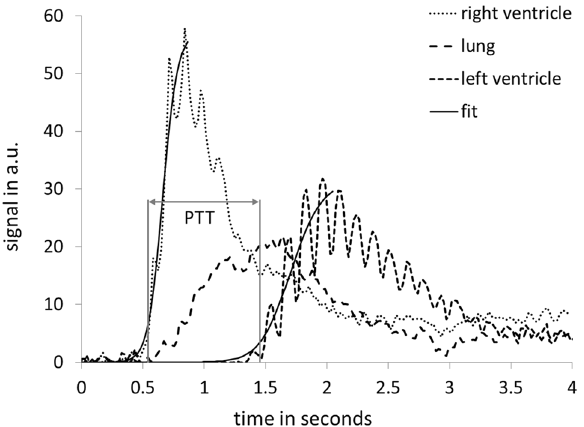
Figure 3. First pass in three phases: the signal time curves measured by magnetic particle imaging show a change in intensities caused by the inflow of tracer into the right and left ventricle as well as in the lungs of a mouse. The three curves are temporally separated due to the sharp bolus profile in the right ventricle. The pulmonary transit time (PTT) describes the delayed arrival in the left ventricle. The observed signal modulation in the left ventricle with a frequency of 7.2 Hz was caused by the cardiac cycle with a RR-interval length of 139 ms.